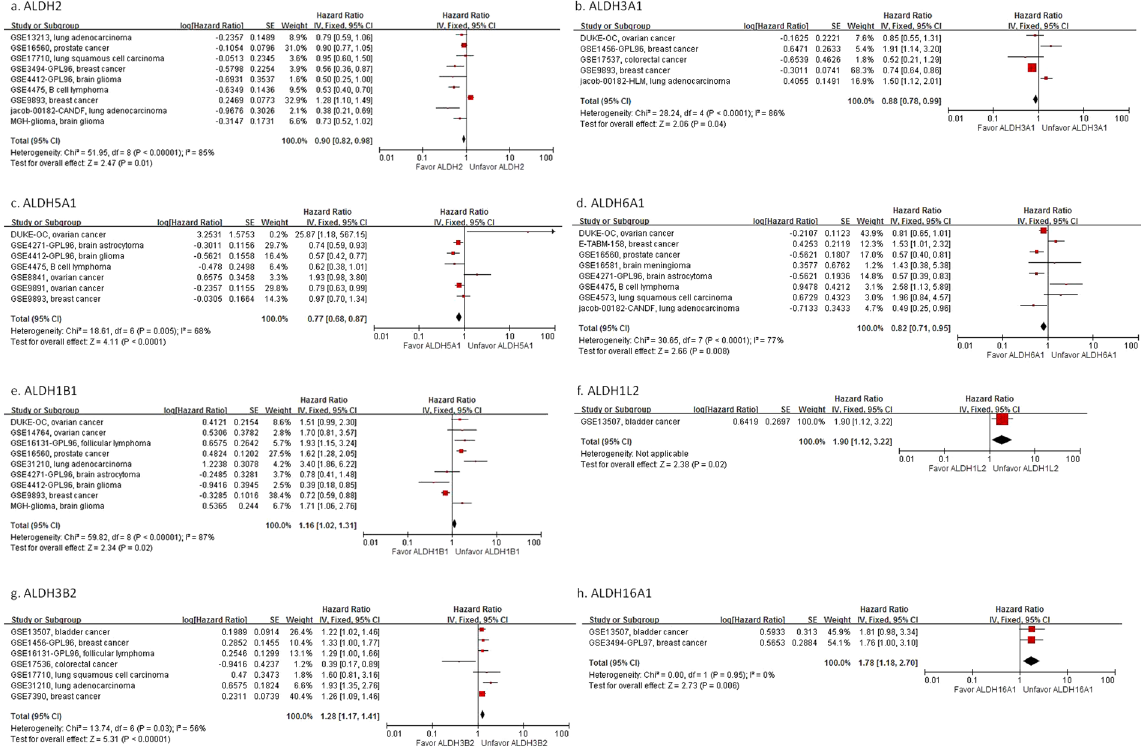
Figure 2. Meta-analysis of overall survival for different ALDH isoforms. “Favor” indicates expression of candidate ALDH toward better a prognosis, whereas “Unfavor” indicates expression toward poorer prognosis. Lower expression of ALDH2, ALDH3A1, ALDH5A1 and ALDH6A1 but higher expression of ALDH1B1, ALDH1L2, ALDH3B2 and ALDH16A1 in tumors was associated with poorer overall survival. ( a ) ALDH2; ( b